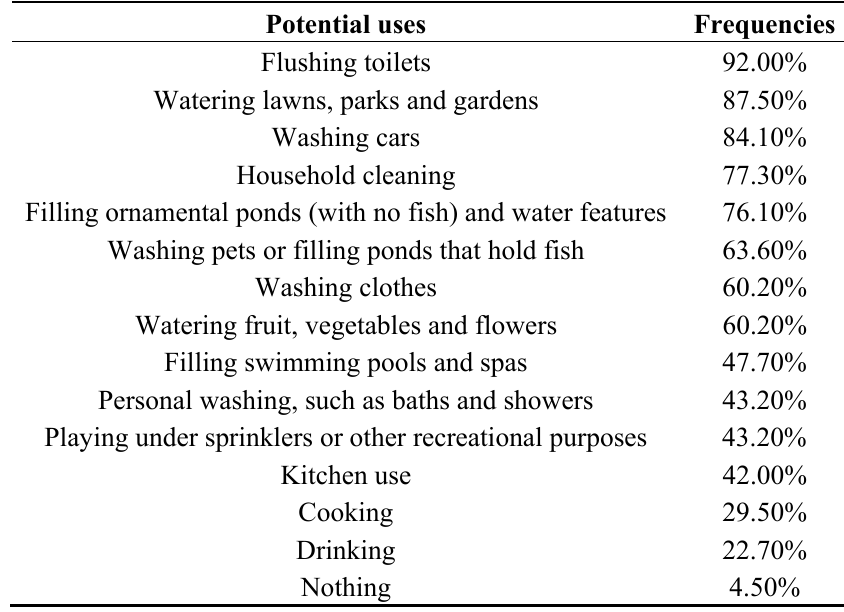
Table 2. What do you think the stormwater treated through the MAR process should be used for? Potential